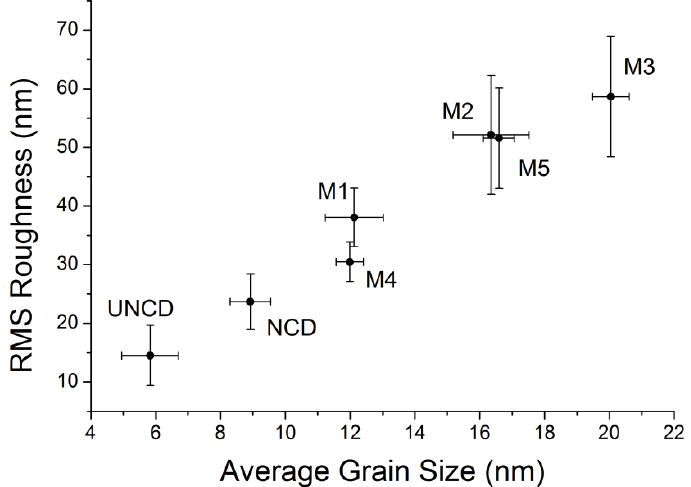
Figure 6. Average RMS surface roughness as related to average diamond grain size for multilayered, NCD, and UNCD